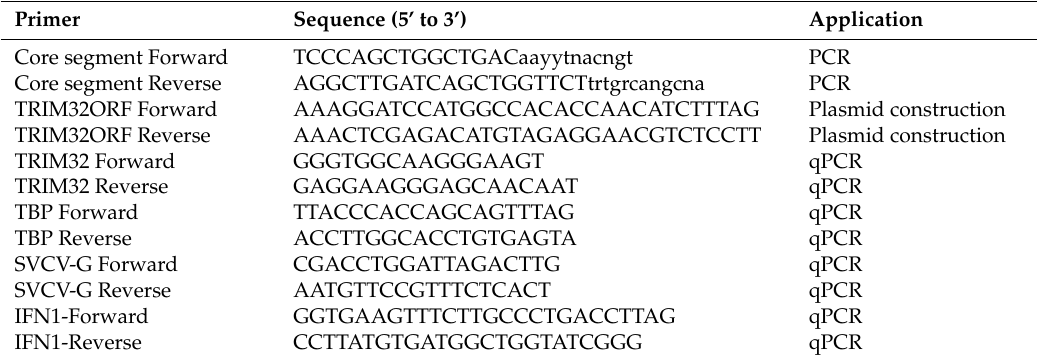
Table 1. Primers used in this